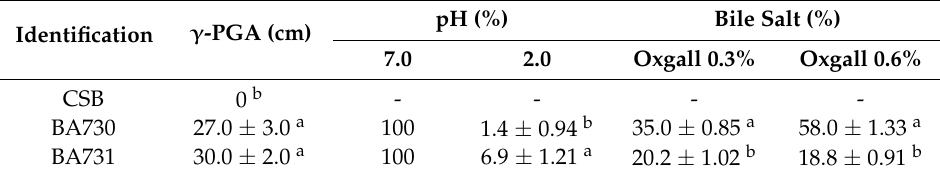
Table 4. γ -PGA contents and survival rates (%) of bacteria in chungkookjangs under different pH and bile